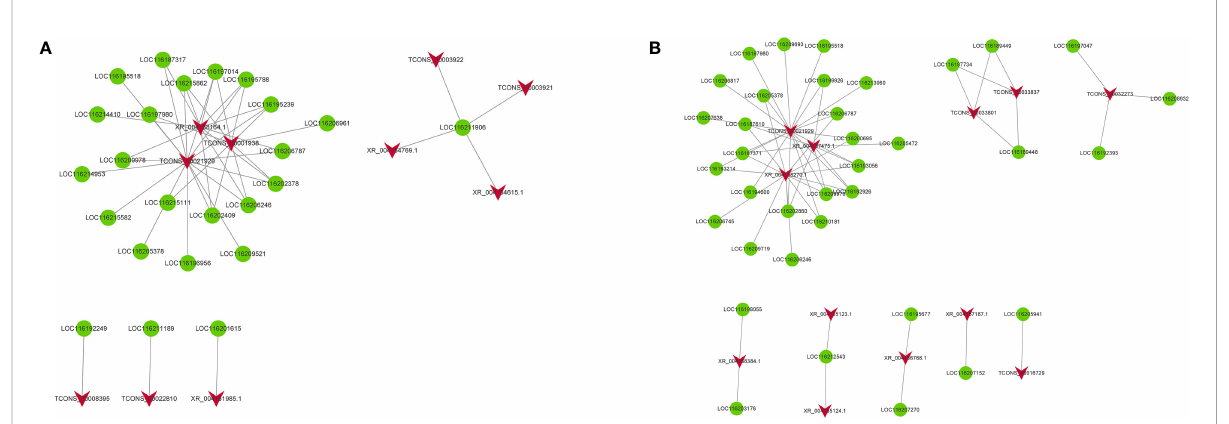
FIGURE 8 The coexpression network of trans-acting differentially expressed lncRNAs (DELs) and differentially expressed mRNAs (DEGs) in FC vs FNC (A) and FB vs FC (B) . The red arrow node and the green circular node represent DELs and DEGs.